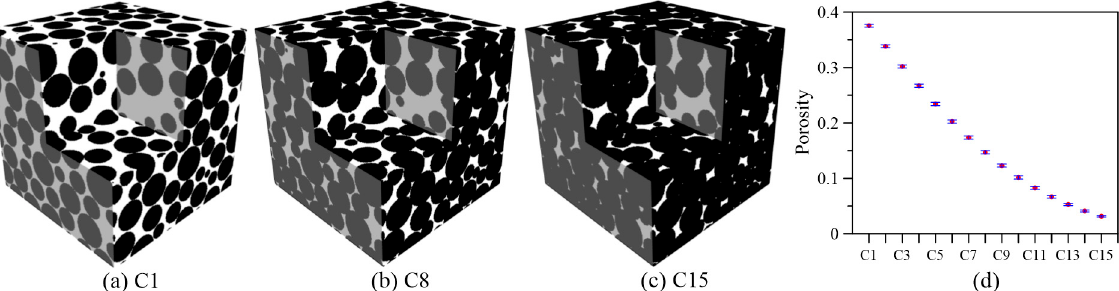
Figure 5. Digital 3D images and porosity evolution of cementation model. ( a – c ) are C1, C8, and C15 sub-models, respectively; ( d ) Porosity evolution.